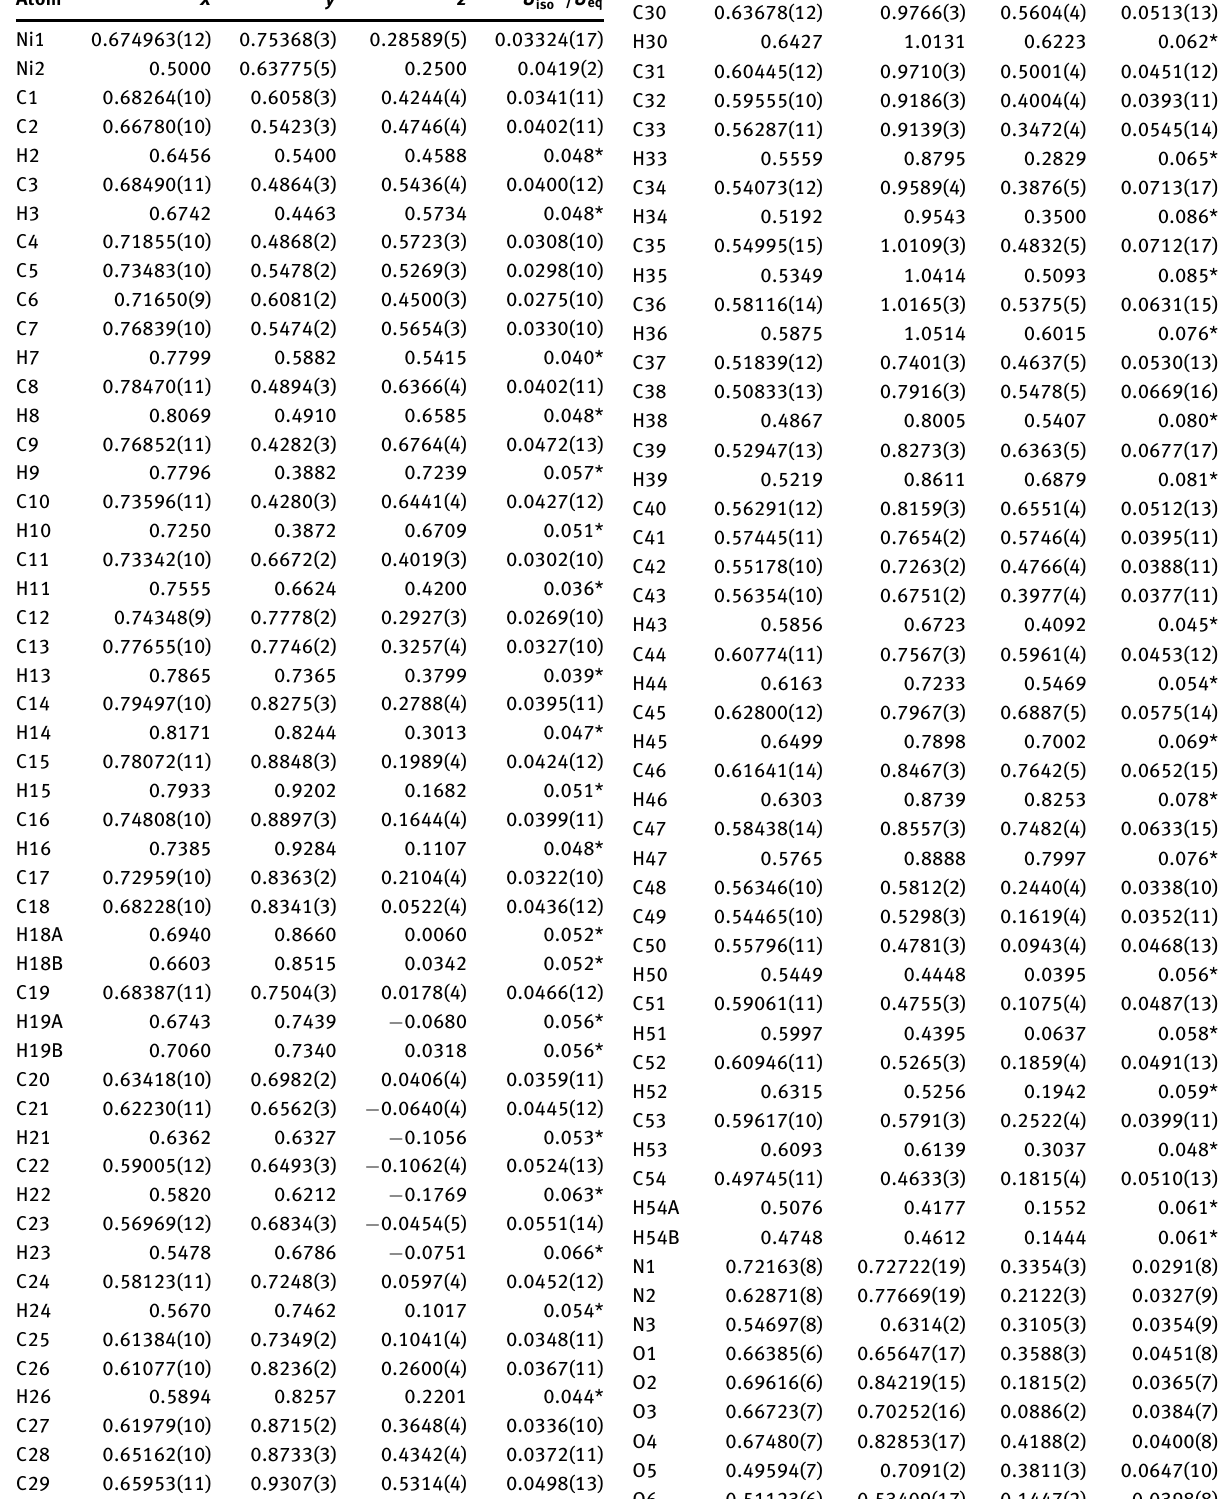
Table 2: Fractional atomic coordinates and isotropic or equivalent isotropic displacement parameters (Å 2